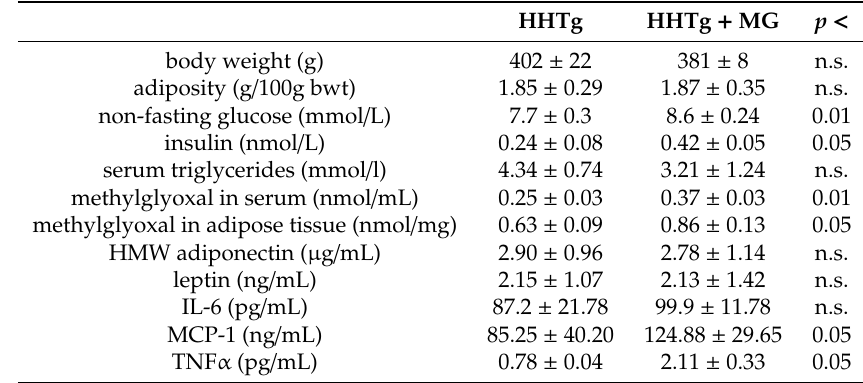
Table 1. Metabolic and inflammatory parameters in serum and tissue in hereditary hypetriglyceridaemic (HHTg) rats and in rats supplemented with methylglyoxal (HHTg +